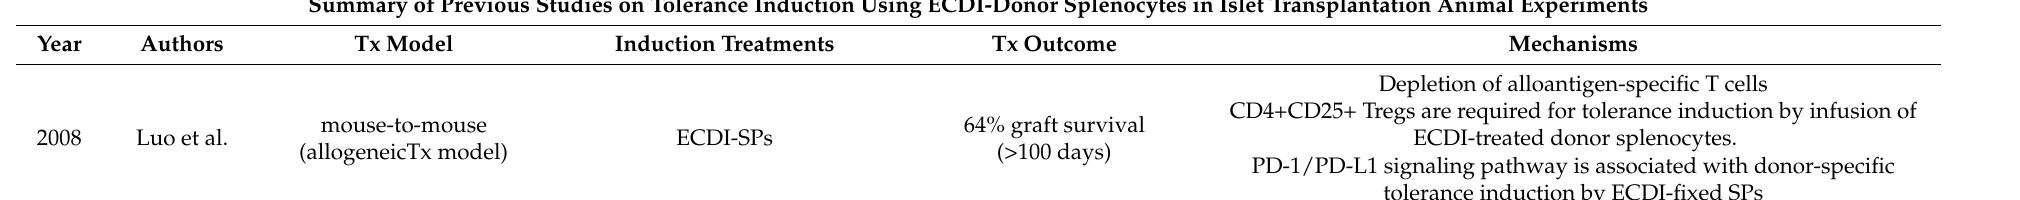
Table 1. Summary of previous studies on tolerance induction using ECDI-donor splenocytes in islet transplantation animal